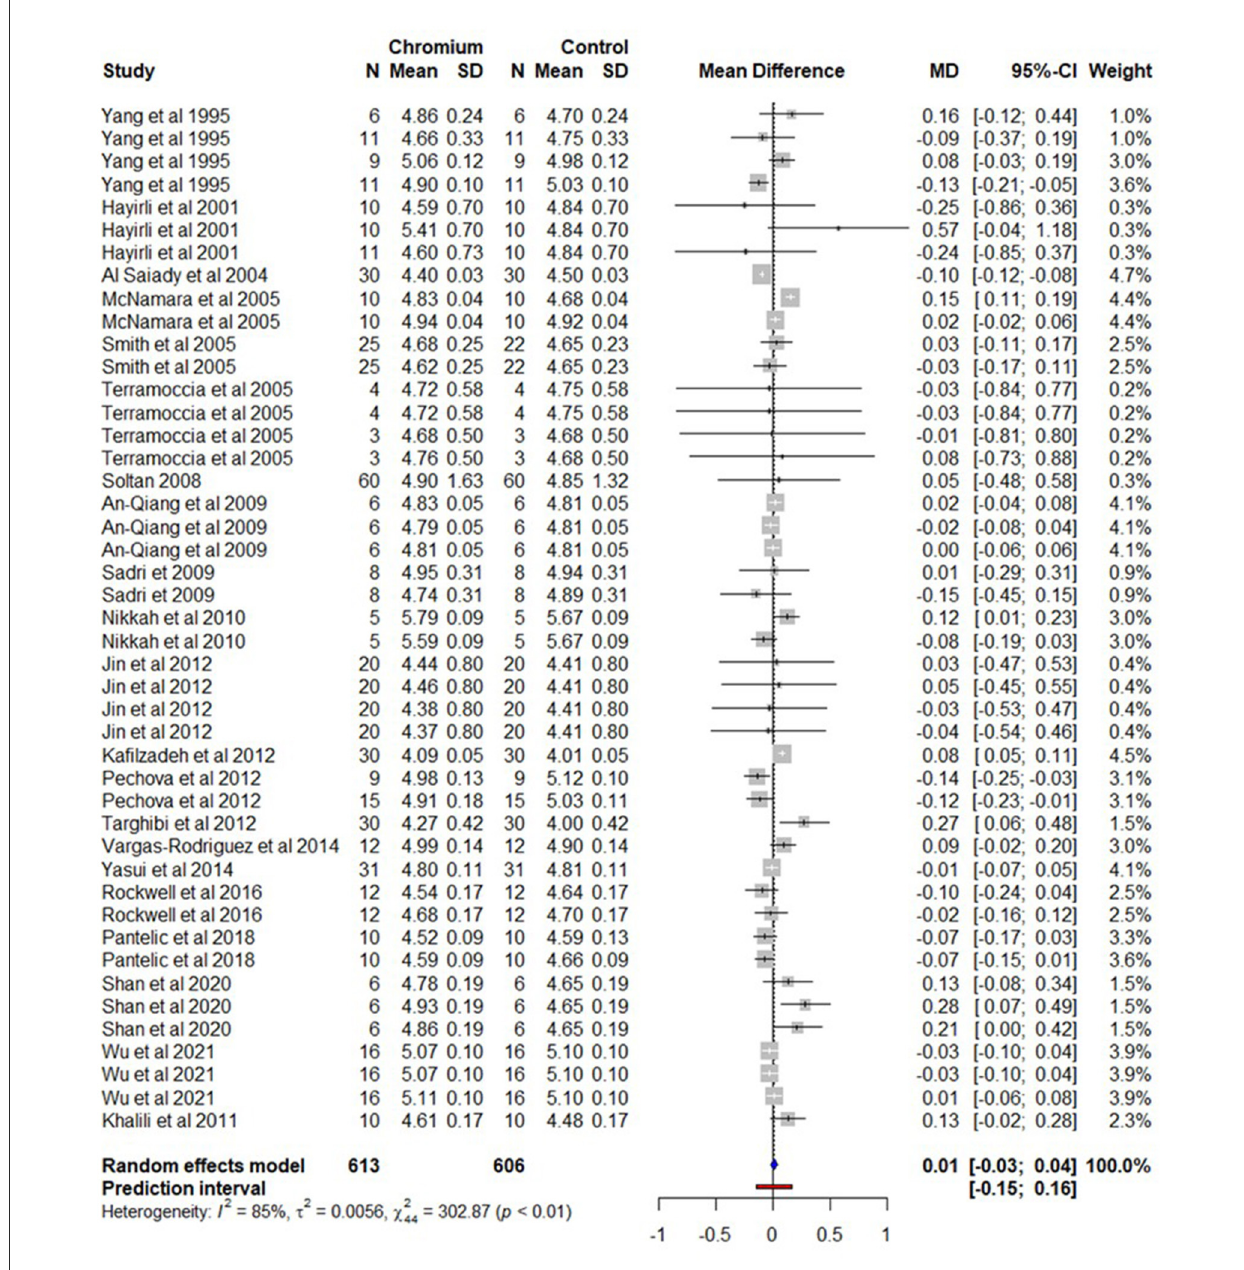
FIGURE6 The forest plot of the random-effect meta-analysis for milk lactose content. The effect size was calculated as the mean difference (MD), and the solid vertical line represents the line of no effect or zero line. The dotted vertical line represents the average effect size for milk lactose content in cows supplemented with chromium. The negative value under the MD heading indicates a decrease in milk lactose content and vice versa. The black horizontal line represents the confidence interval for each study and the gray square represents weight or effect size of the corresponding study. The blue diamond represents the average effect size of the